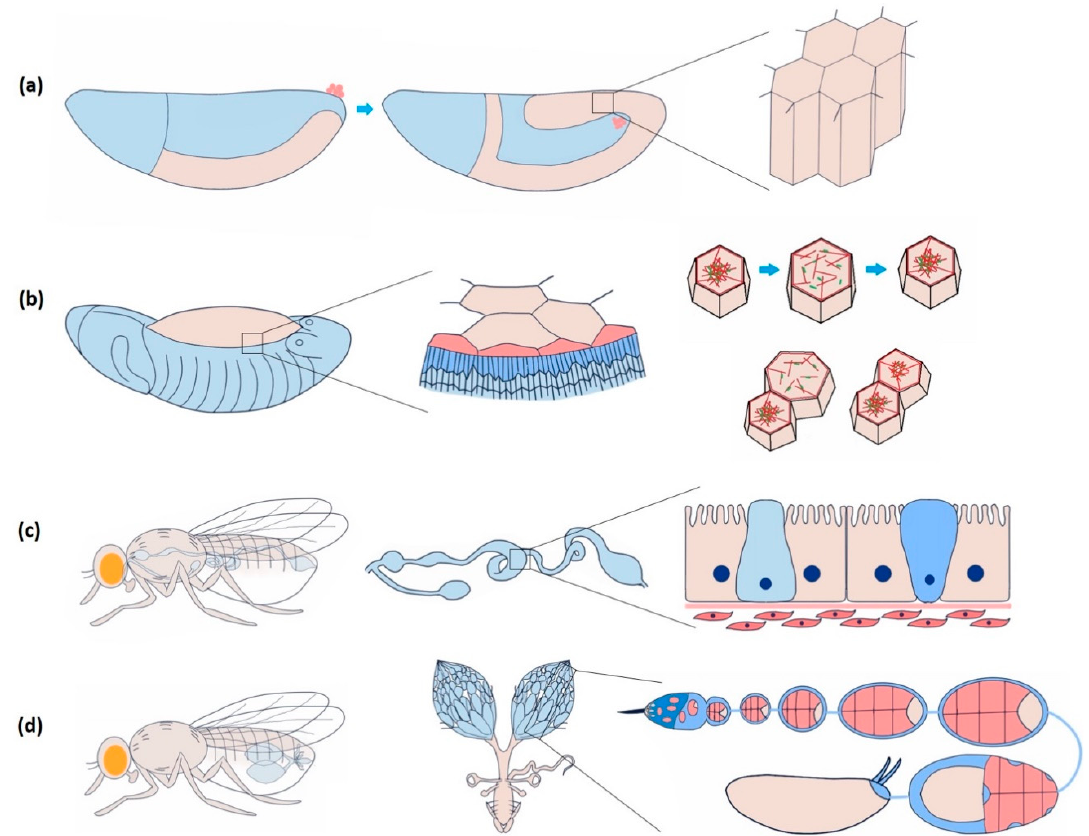
Figure 2. Dynamic epithelial tissues during morphogenesis and homeostasis in Drosophila . ( a ) Highly dynamic columnar epithelial cells of the germband during germband extension. The frequency of Ca 2+ spikes increases during the first fast phase of germband extension, though the correlation with cell and junction dynamics are still unclear. ( b ) Periodically oscillating squamous epithelial cells of amnioserosa before dorsal closure. Neighbouring cells are either positively (contract and relax together) or negatively (when one contracts, the other relaxes and vice versa) coupled. Negative coupling maintains the tissue area and integrity, whereas positive coupling induces closure. Ca 2+ influx is sufficient to induce cell contraction guided by actomyosin assembly. ( c ) Drosophila midgut comprises a diverse group of cuboidal epithelial cells: enterocyte with microvilli for absorption, intestinal stem cell (light blue) for regeneration and proliferation, and enteroendocrine cell (dark blue) for secretion. Ca 2+ induces proliferation of the intestinal stem cells. Piezo-mediated Ca 2+ is attributed to initiating the differentiation of the enteroendocrine cells. ( d ) The Drosophila ovary consists of a series of developing egg chambers. A dense monolayer of somatic epithelial cells called follicle cells surrounds a single oocyte and 15 supporting nurse cells in each egg chamber. Egg chamber elongation largely depends on the asynchronous oscillation of these cells, which Ca 2+ regulates.